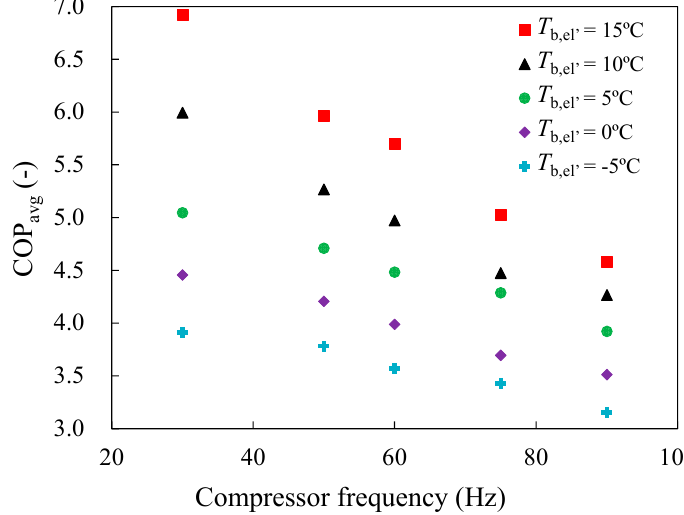
Figure 6. The heating coefficient of performance (COP) avg as a function of compressor frequency.